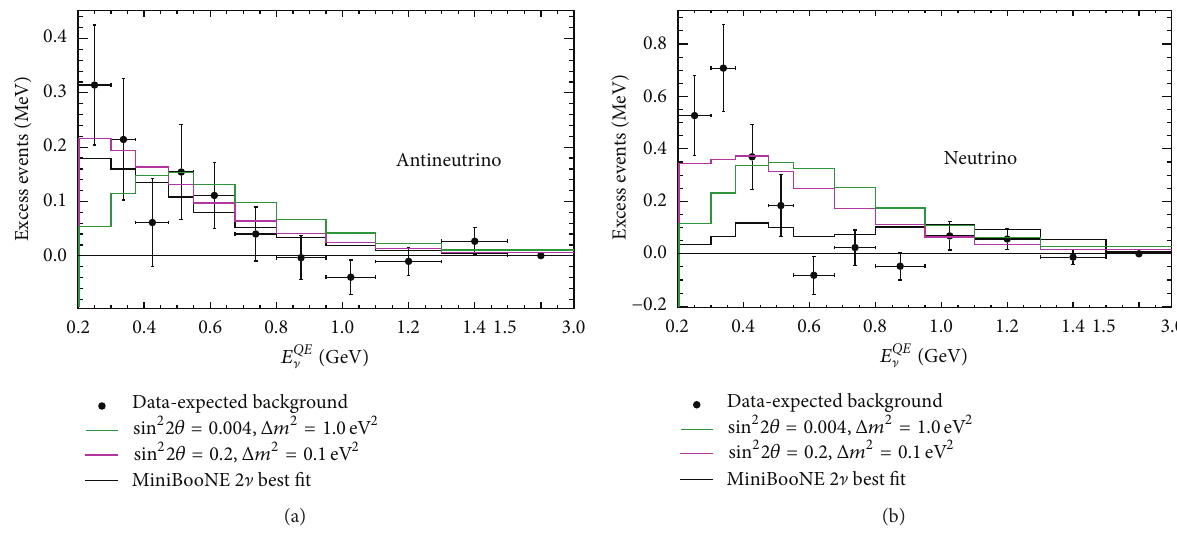
Figure 13: The MiniBooNE neutrino mode (a) and antineutrino mode (b) event excesses as a function of neutrino energy. Also the expectations from the best two-neutrino oscillation fits with neutrino energy from 200 to 3000 MeV and from two reference values in the LSND allowed region are shown. All known systematic errors are included in the systematic error estimate.